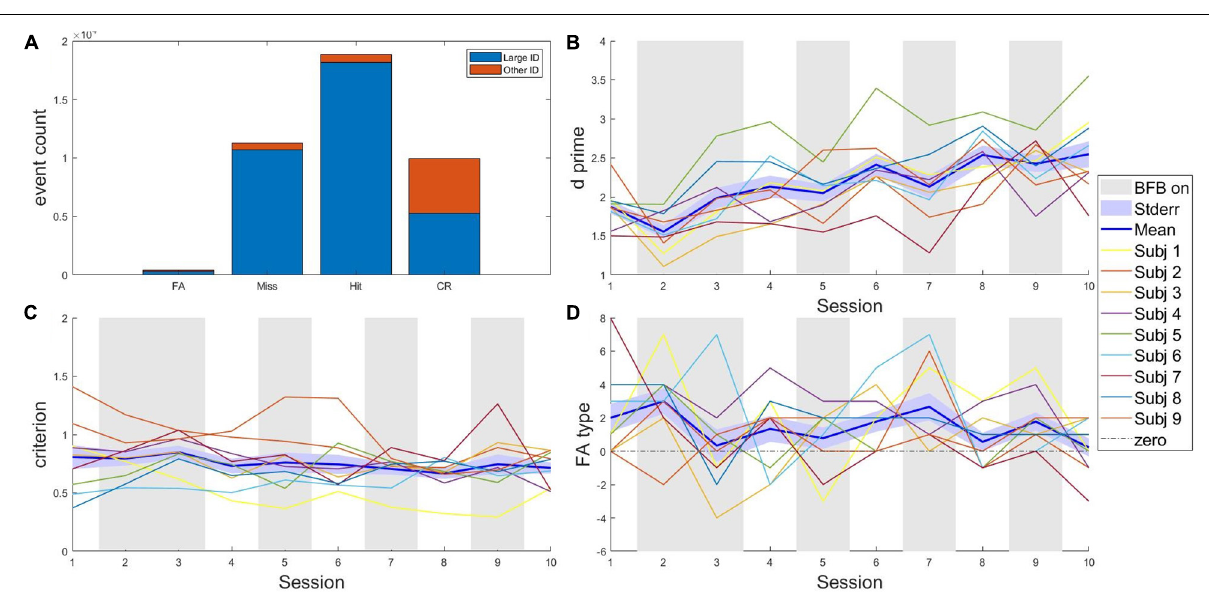
FIGURE 3 | Behavioral metrics (in-game). (A) Go/nogo action distributions across sessions and subjects. Columns are sub-divided according to the large identifier of the target related to the trial. (B) d’ from signal detection theory indicating sensitivity to target type (hostile/friendly); (C) criterion from signal detection theory indicating potential changes in strategy (D) Difference score of false alarm depending on the body type (primed body type—unprimed body type); Hit, hit; CR, correct rejection; FA, false alarm; Miss, misses; large ID, has the primed body type, announced as presumably hostile in radio dispatch; other ID, does not have a body type announced as presumably hostile in radio dispatch; BFB on, Sessions in which online biofeedback was presented to the participants; Stderr, standard